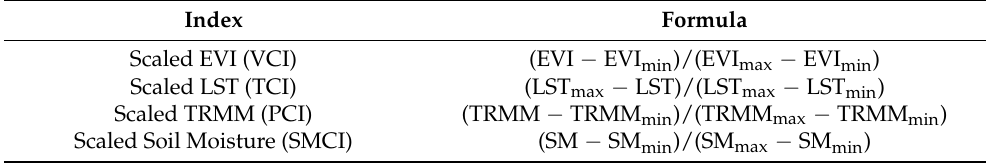
Table 2. Formulas for the scaled